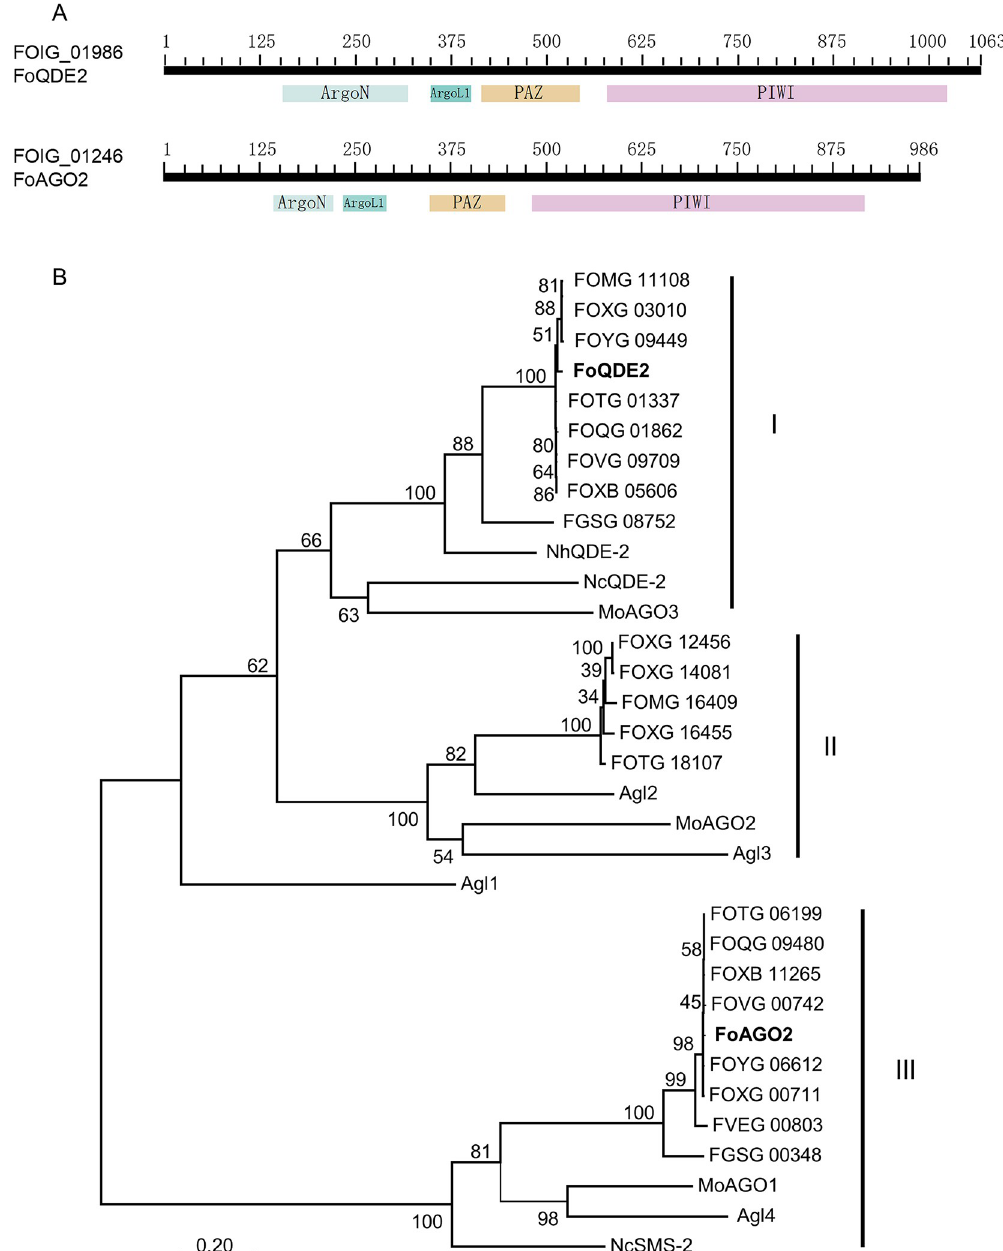
Fig 1. Phylogenetic analysis of fungal Argonaute proteins. ( A ) Conserved domains of Argonaute proteins were predicted through BLASTp on NCBI. ( B ) Fungal Argonaute protein sequences were first aligned using Clustal × 1.8 and then the aligned sequences were analyzed by the Maximum Likelihood method implemented in MEGA 7. Bootstrap values are expressed as a percentage of 1000 replicates. In addition to Argonaute proteins from the Fusarium oxysporum f. sp. cubense ( Foc ) genome showed in bold, proteins used for this analysis include Agl1–Agl4 from Cryphonectria parasitica [28], a chestnut blight fungus; MoAGO1–MoAGO3 from Magnaporthe oryzae , a rice blast fungus [15]; NcQDE2 and NcSMS-2 from the model fungus Neurospora crassa [25]; and proteins from the F . graminearum (FGSG), F . verticillioides (FVEG), and F . oxysporum (FOVG: GCA_000260075.2; FOQG: GCA_000260235.2; FOTG: GCA_000260175.2; FOMG: GCA_000260495.2; FOXG: GCA_000149955.2; and FOYG: GCA_000271745.2) genomes.